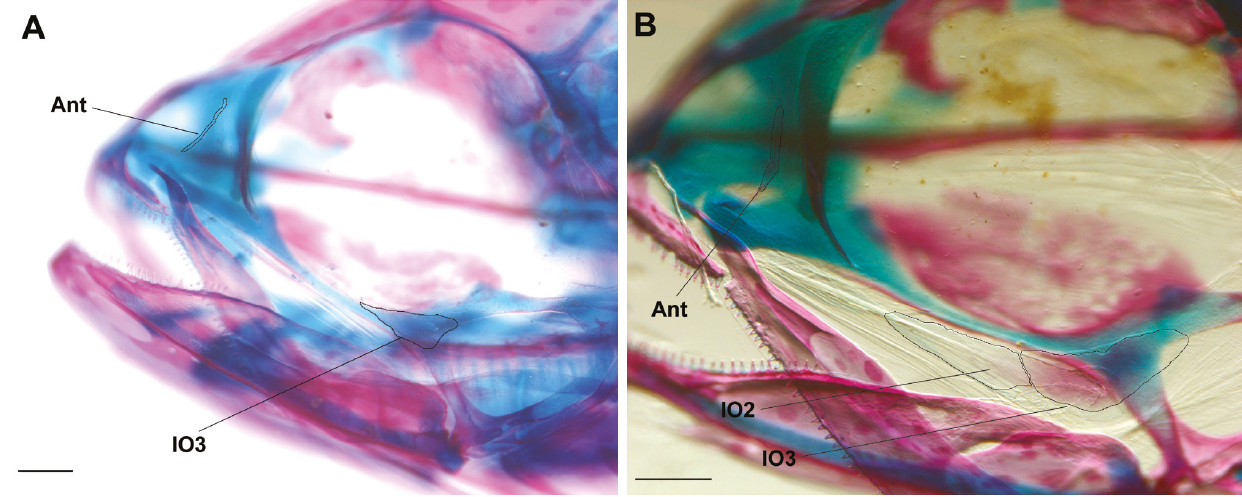
FIGURE 2 | Priocharax britzi , paratypes, MZUSP 125823, c&s; anterior region of head in lateral view detailing the orbital region. A. 12.5 mm SL. B. 12.9 mm SL, image flipped. Antorbital and infraorbitals delimited by black line for clarity. Ant = antorbital; IO2 – 3 = infraorbitals 2 – 3. Scale bar = 0.2